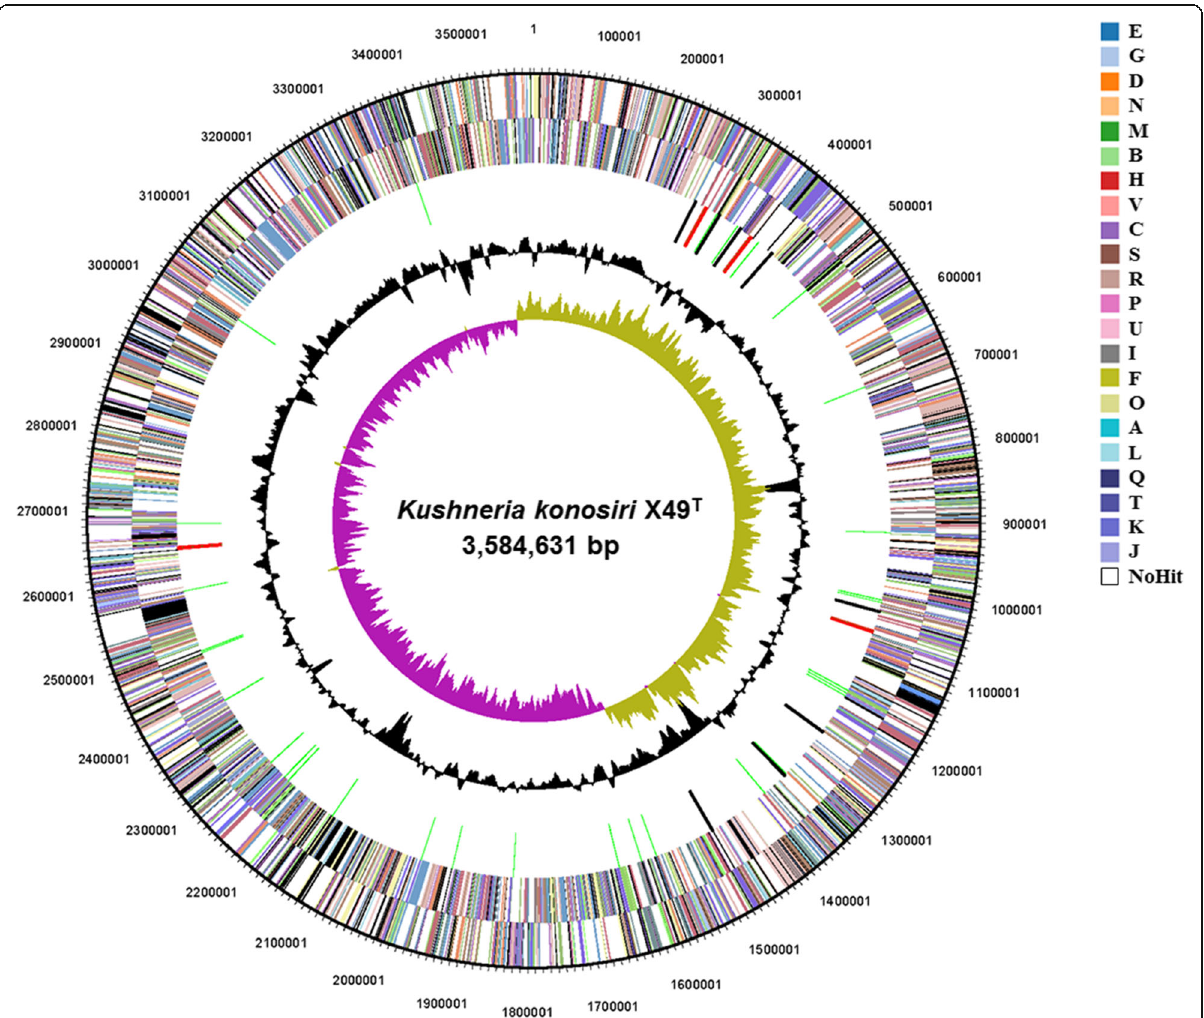
Fig. 3 Circular map of the complete K. konosiri X49 T genome. Marked characteristics are shown from the outside to the center: the number of bases, COG on forward strand, COG on reverse strand, RNA genes (tRNAs, green bars; rRNAs, red bars; other RNAs, black bars), GC content, and GC skew. Individual genes are colored according to COG